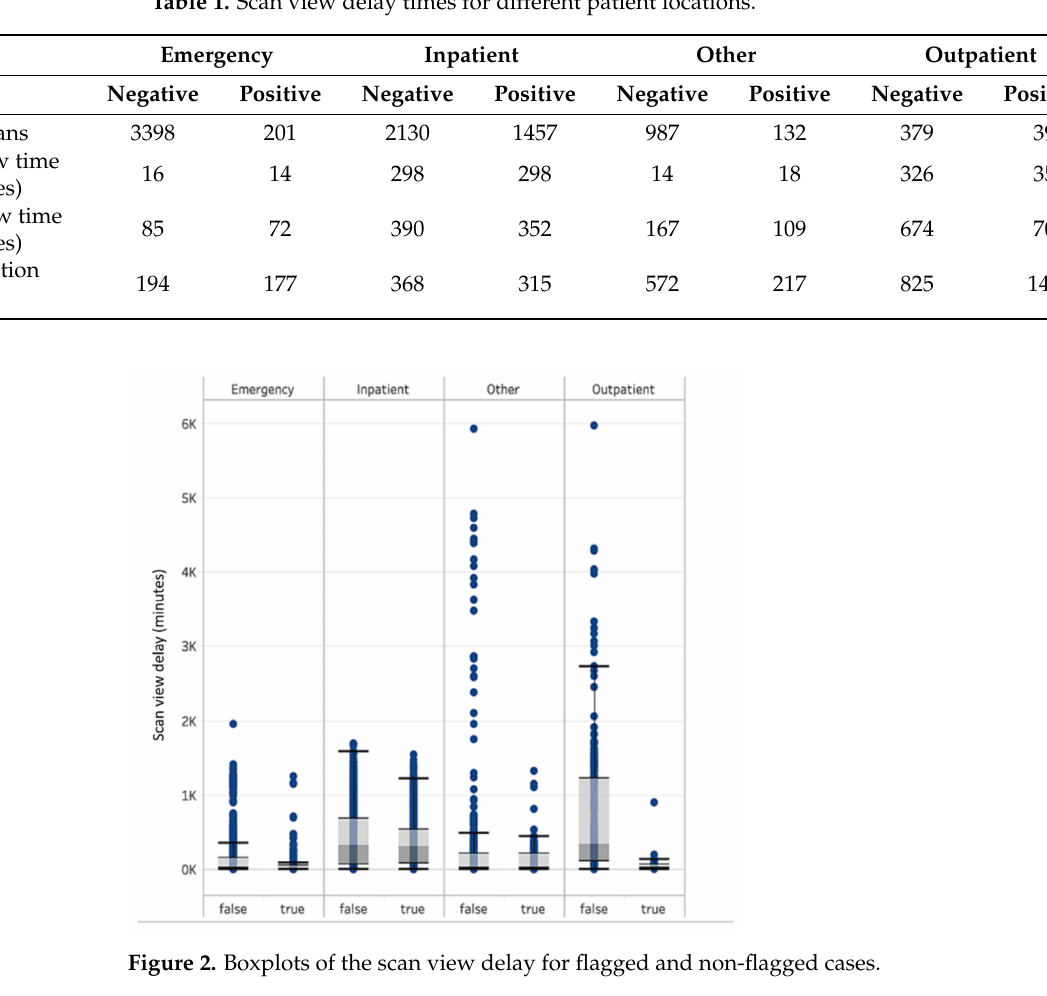
Table 1. Scan view delay times for different patient locations.